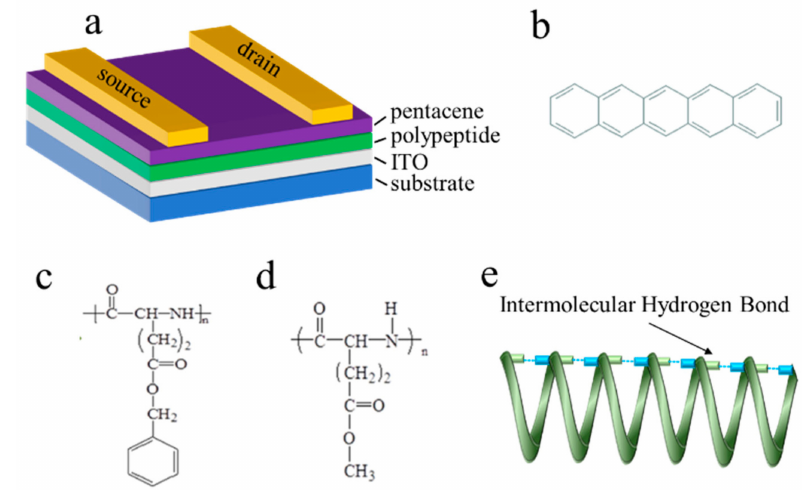
Figure 1. ( a ) The configuration of bottom-gate top-contact BioTFT device with thermally deposited Au as source (S) and drain (D) electrodes, polypeptide as the gate dielectric layer, pentacene is used as the semiconductor, and Indium tin oxide (ITO) as the gate electrode. The chemical structures of ( b ) pentacene, ( c ) poly ( γ -benzyl- l -glutamate) (PBLG) and ( d ) poly ( γ -methyl- l -glutamate) (PMLG). ( e ) The α helix structure of polypeptide